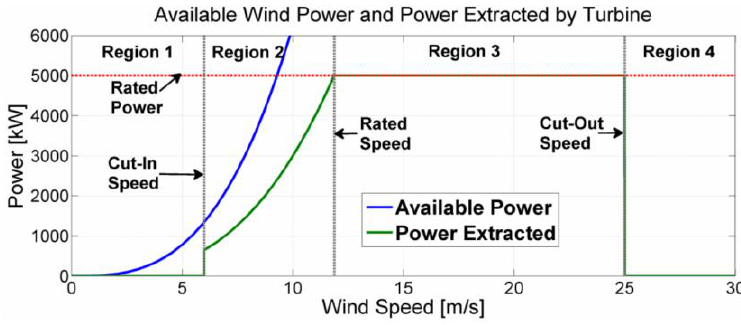
Figure 2. Wind turbine operation regions as a function of wind speed [40].